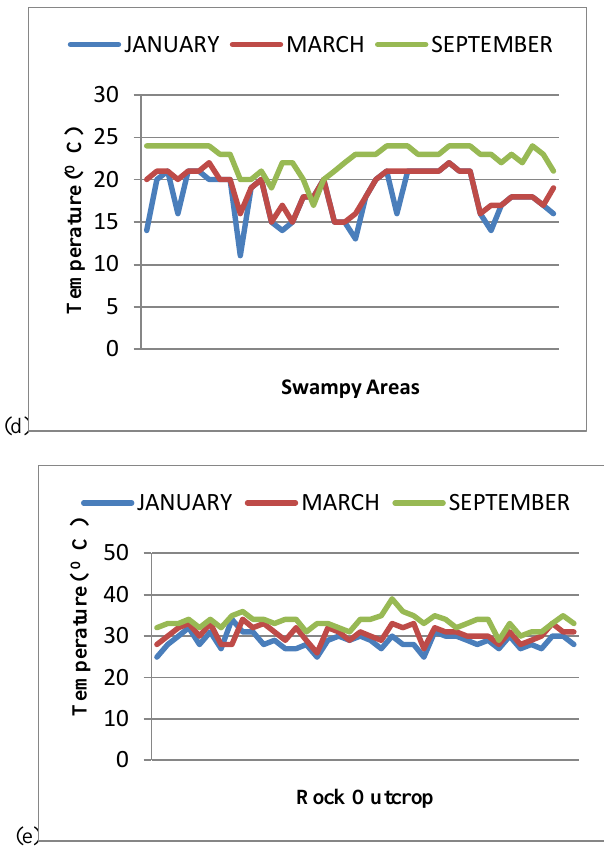
Figure 9: Inter-seasonal variation of surface temperature across land use/cover categories: (a) water bodies (b) vegetation; (c) built-up land; (d) swampy area; (e) rock outcrop.